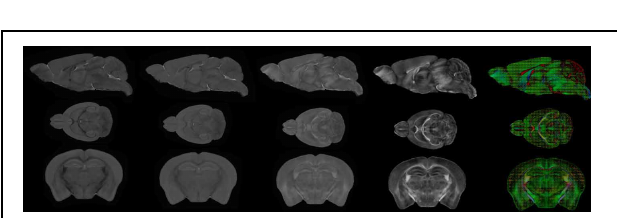
FIGURE 8 | Population average computation pipeline output. From top to bottom: sagittal view, axial view, coronal view. From left to right: RD image, MD image, AD image, FA image, color-coded FA with ellipsoids representing the tensors